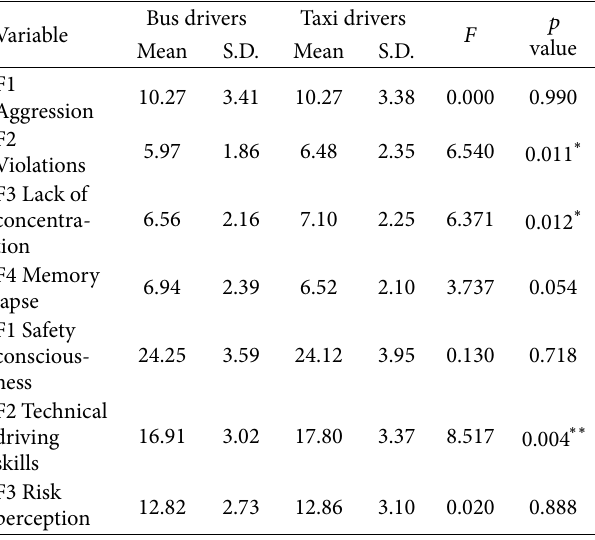
Table 5: Differences in driving behaviors and driving skills between bus drivers and taxi